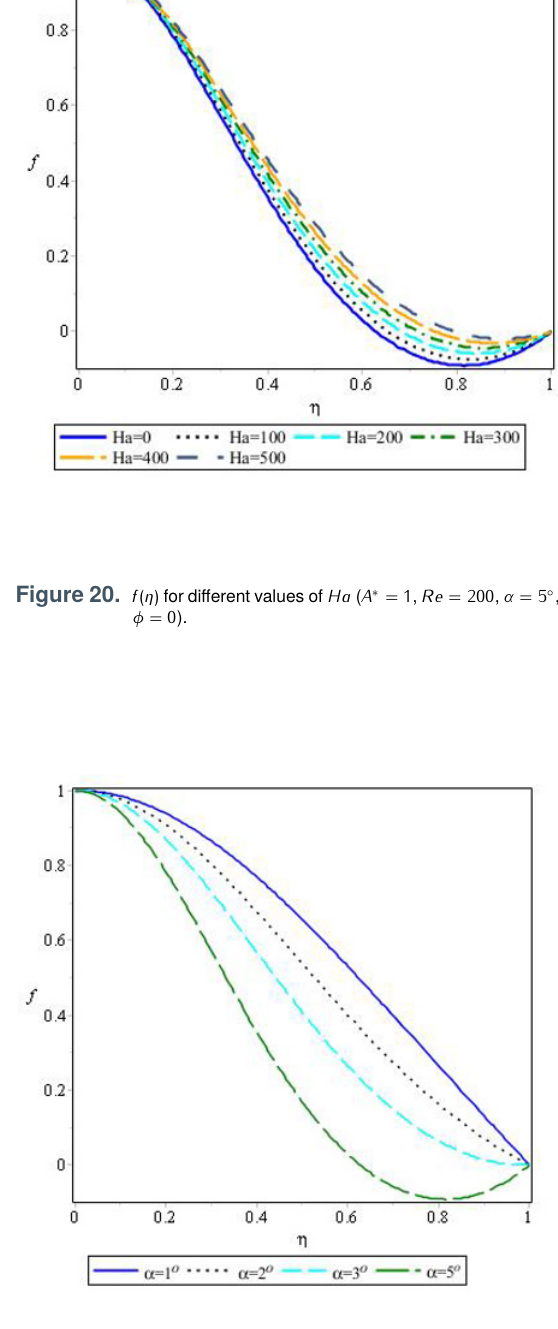
Figure 19. f ( η ) for different values of Ha ( A ∗ = 1 , Re = 200 , α = 1 ◦ , φ = 0 ).